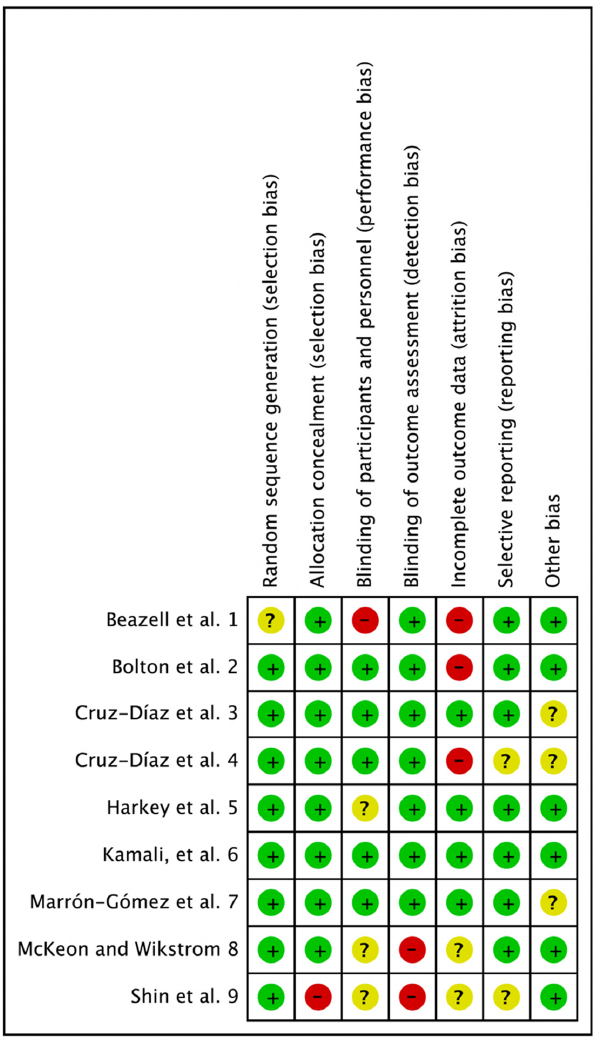
Figure 2. Risk of bias summary: review of authors’ judgements about each risk of bias item for each included study. 1-[18], 2-[23], 3-[19], 4-[17], 5-[25], 6-[24], 7-[22], 8-[21],